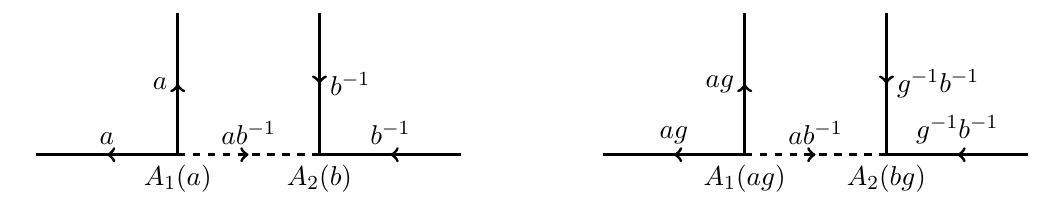
Figure 9 . An illustration of the action of A v located at the physical boundary before and after they are shifted by a common group element g